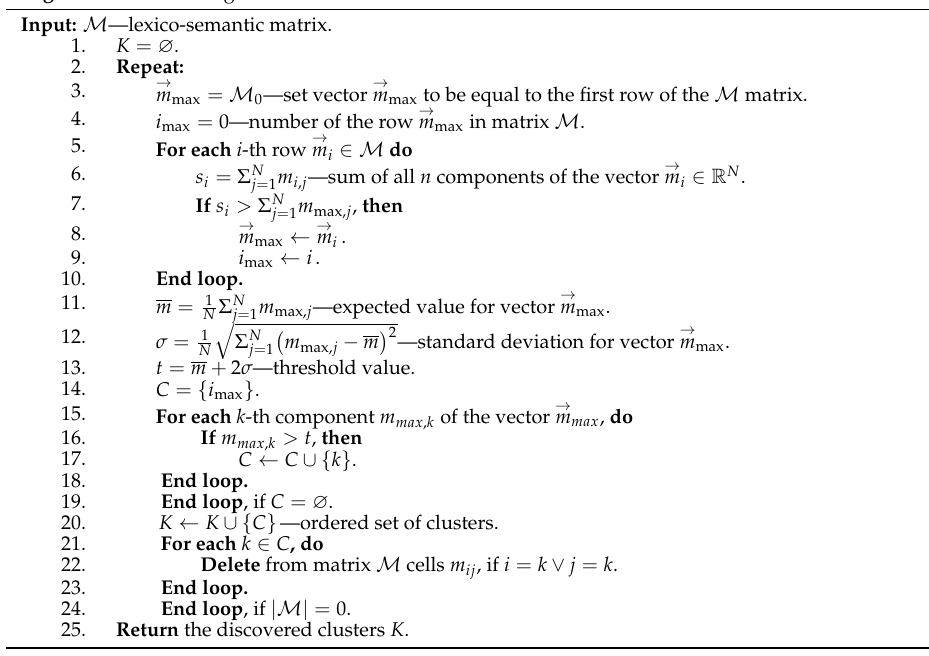
Algorithm 2: Clustering text documents based on their lexico-semantic